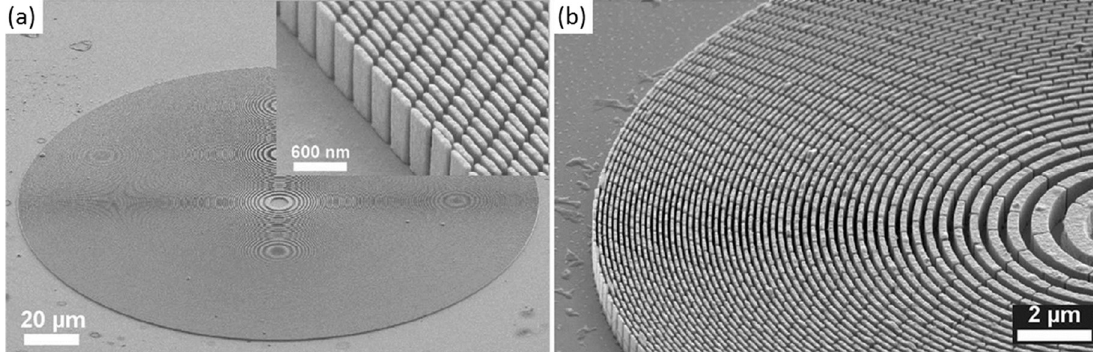
Figure 13. ( a ) Fresnel zone plate fabricated by e-beam writing, ( b ) magnified fiew of the fresnel zone plate. Reproduced with permission from [138].